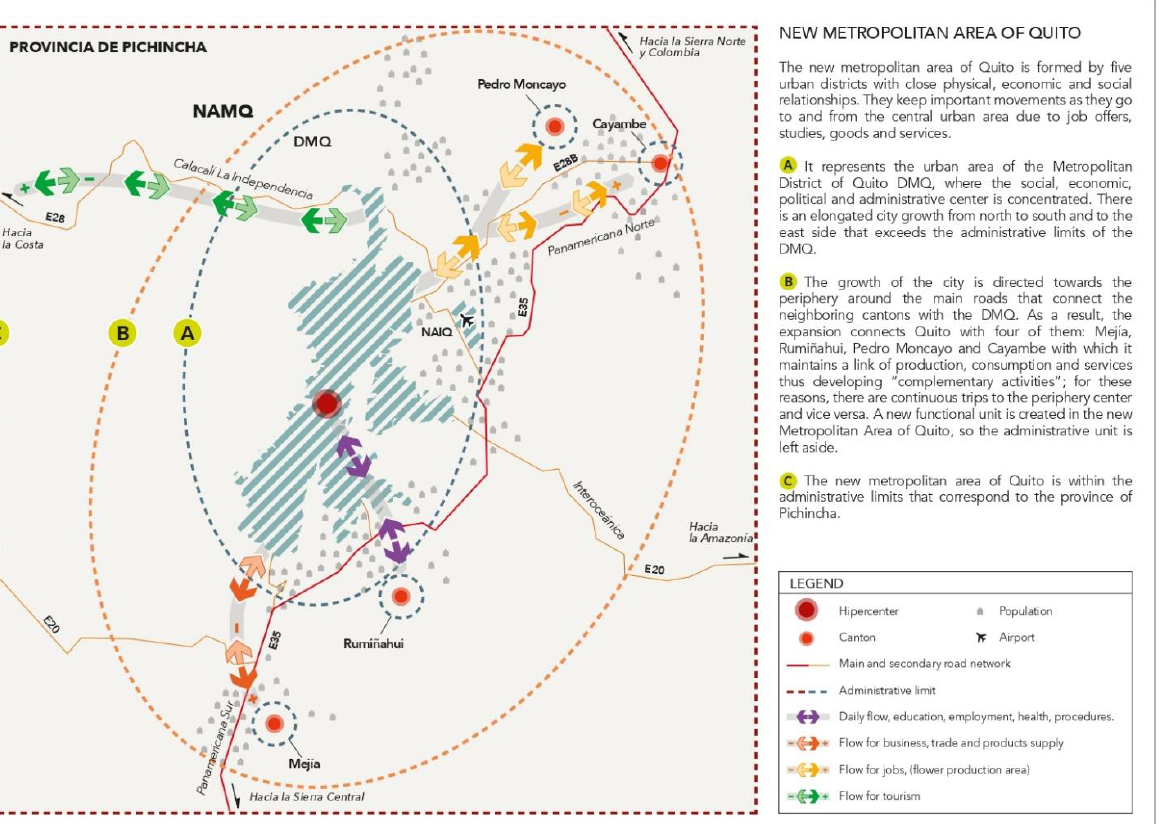
Figure 8. Model of the new metropolitan area of Quito. Own elaboration.